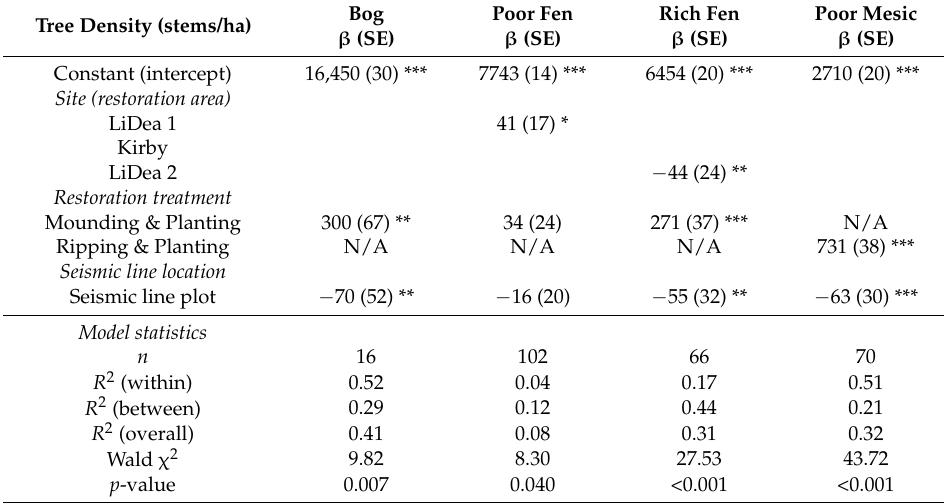
Table 2. Random effect linear model (xtreg) parameters (coefficient, β ; and standard error, SE) relating regeneration density (DBH < 1 cm) (log 10 transformed) of all tree species to all three restoration areas, restoration treatment (mounding and planting or ripping and planting), and seismic line location (vs. adjacent forest control). Both restoration treatment and seismic line location were included regardless of significance. *** p < 0.001, ** p < 0.01, * p < 0.05.